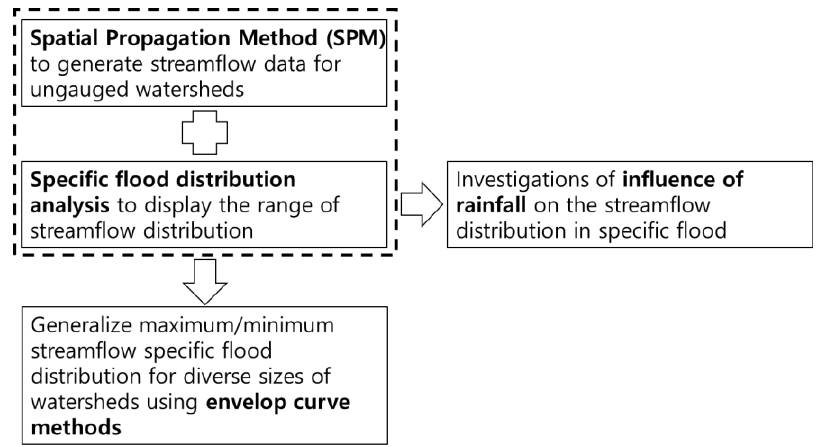
Figure 2. Methodology to represent the range of the streamflow distribution and additional studies related to the specific flood distribution.